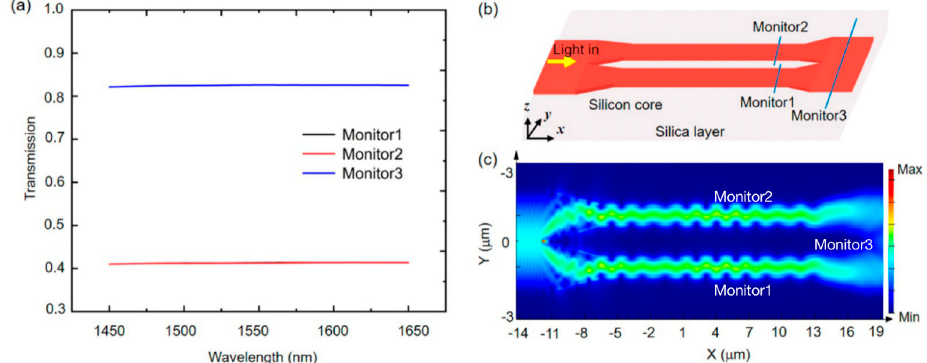
Figure 5. ( a ) The transmission spectra of the Y-junction power splitter and combiner. ( b ) The structure of the power splitter (at the incident end) and combiner (at the exit end). ( c ) The electric field distribution near 1550 nm at the x–y plane when z = 0.